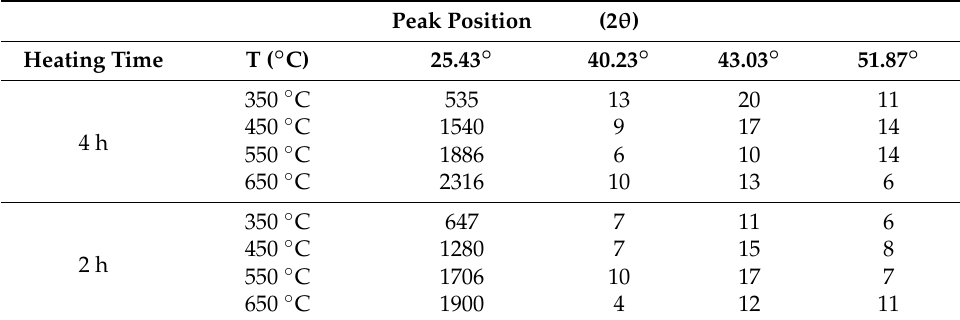
Table 6. Major peaks in the formation of anhydrite from the calcination of phosphogypsum. Peak Position (2 θ ) Peak Position (2 θ ) Heating Time T (°C) Heating Time T ( ◦